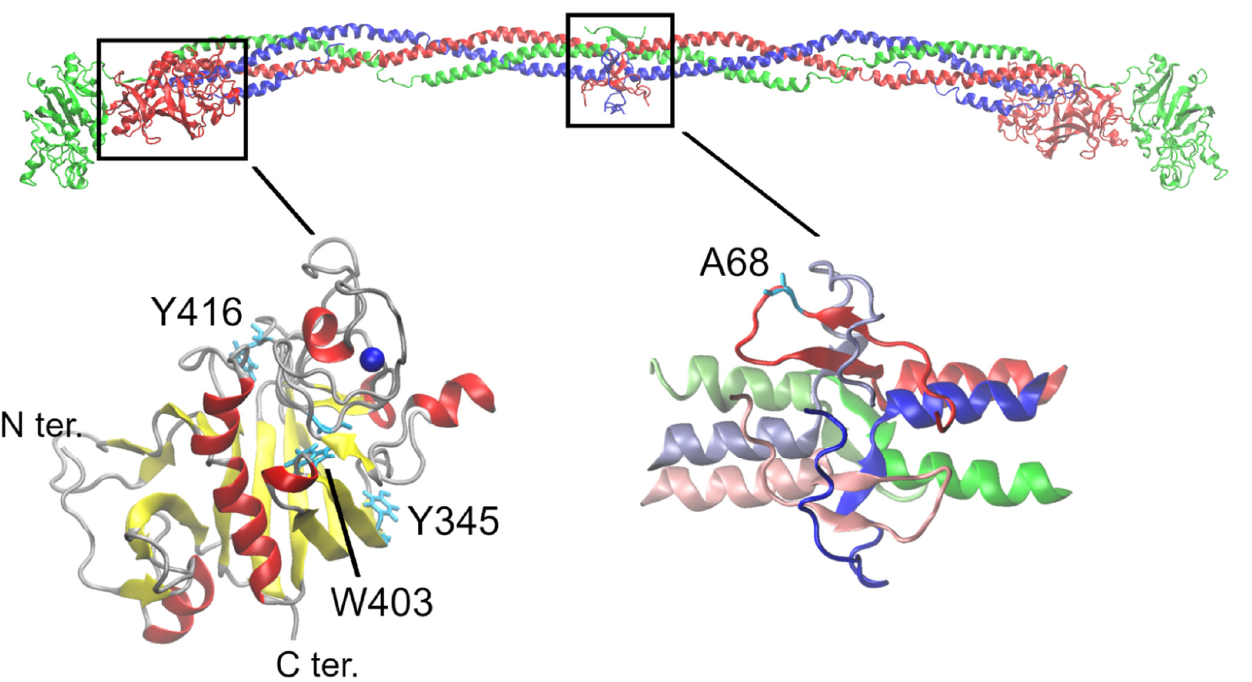
Figure 5. Position of the mutated amino acids within fibrinogen. Above: Black boxes overlaying the crystal structure 3GHG show regions where the detected mutations are situated. A α chain is shown in blue, B β chain in red, and γ chain in green. Below left: fibrinogen-related domain of the Bb chain; three mutated amino acids are shown in cyan. Below right: adjusted part of the E-domain of fibrinogen that was the subject of homology modeling with shown amino acid BbA68. Chains of the second half-molecule are depicted in light colors.